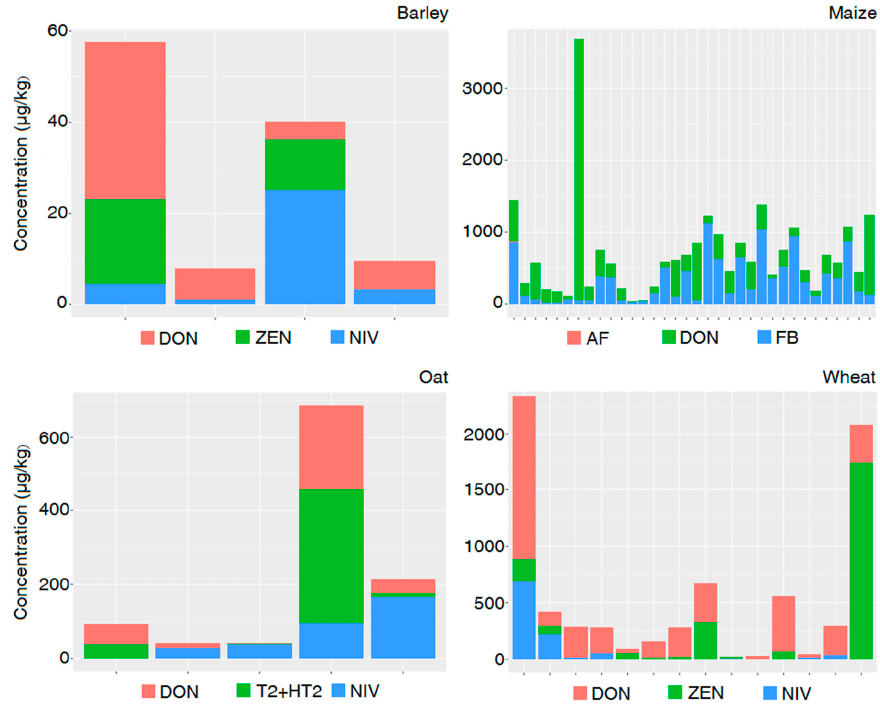
Figure 7. Concentrations of each co-occurring mycotoxin for barley, maize, oat, and wheat.